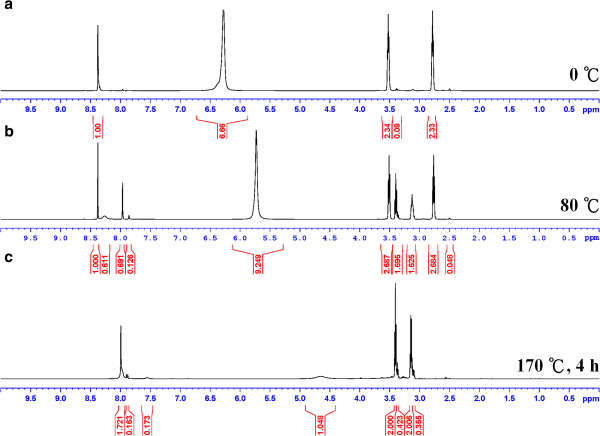
1H NMR spectra of 2-hydroxyethanaminium formate synthesized. (a) At 0°C, (b) at 80°C, and (c) the resultant1H NMR from (a) upon heating at 170°C for 4 h.